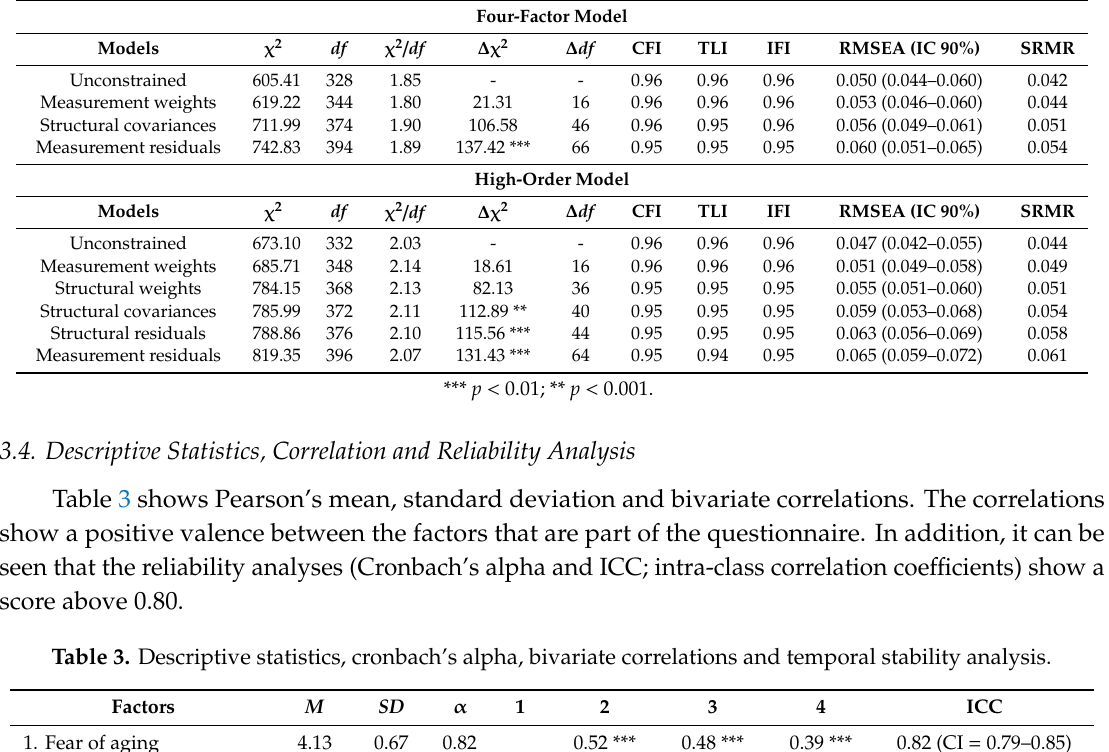
Table 2. Gender invariance analysis.